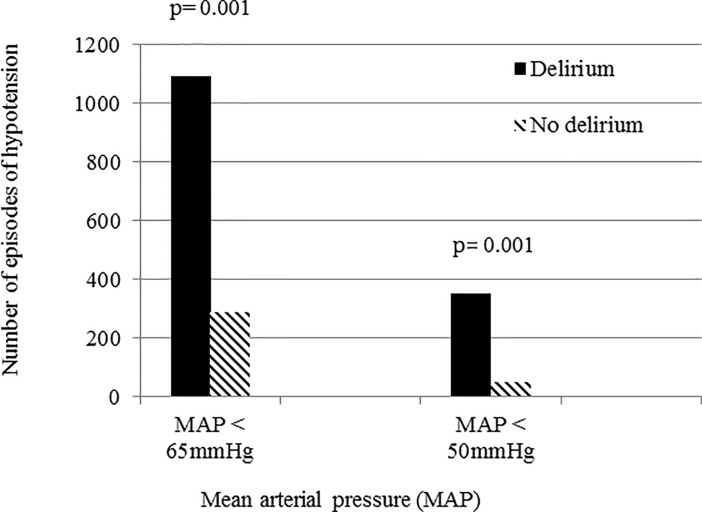
Number of episodes of hypotension in patients who developed delirium and those who did not.